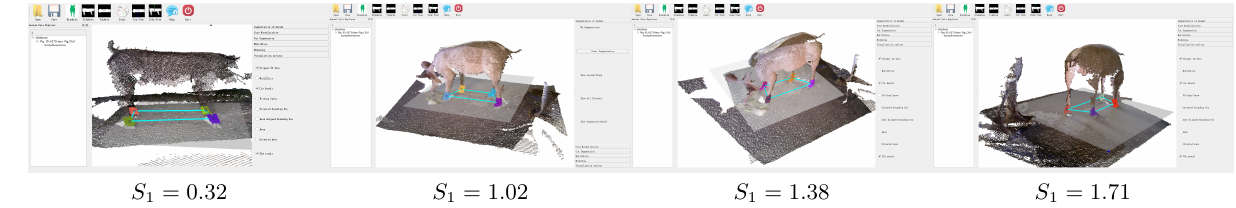
Figure 10. Illustration of frames with different posture and its corresponding S 1 value in